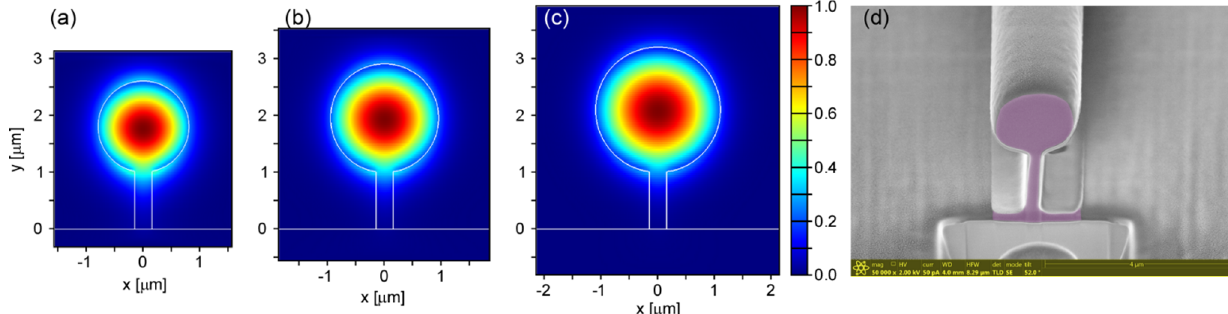
Figure 1. Simulated mode field profiles of nano-fin supported, single mode waveguides (vertically polarized) for core diameters of ( a ) 1.6 µm, ( b ) 1.9 µm, and ( c ) 2.2 µm. The ability to fabricate such structures is demonstrated in the cross-section image of our fabricated waveguide (after FIB sectioning, shown in ( d )), viewed at a 52° tilt from vertical.